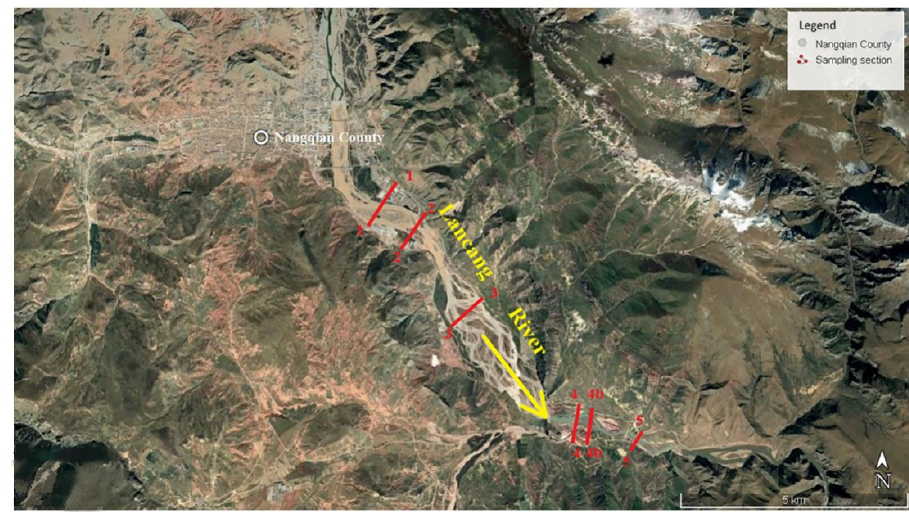
Figure 5. Sampling section distribution along the Lancang River source. (The direction of the arrow is the direction of the river flowing).